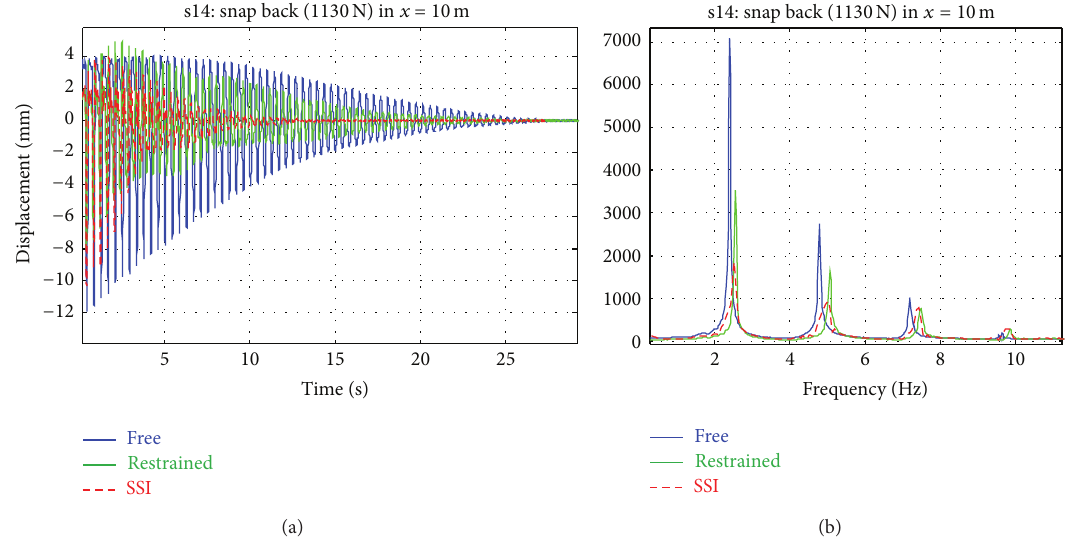
Figure 6: (a) Displacement and (b) associated spectrum at 7.2 m on the free, constraint, and SSI cable no. 2.